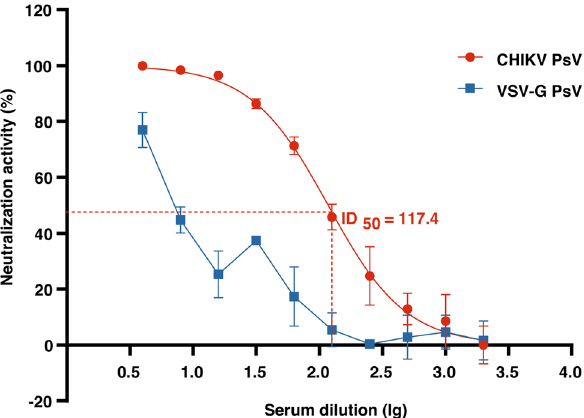
Figure 4. Development of CHIKV PsV micro-neutralization assay. Serially diluted serum from CHIKV- immunized rabbit was incubated with CHIKV or VSV-G PsV. After one-hour incubation, the mixture was transferred to 293T cells. Luciferase activity was measured at 72 h post transduction to evaluate the neutralizing ability of antibody to CHIKV PsV or VSV-G PsV on the microplate reader, followed by the calculation of ID 50 . Error bars show the standard deviations (SD) of results from duplicate independent experiments.